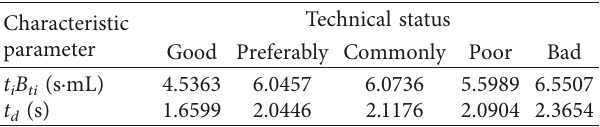
Table 4: Benchmark values for technical status evaluation of a diesel